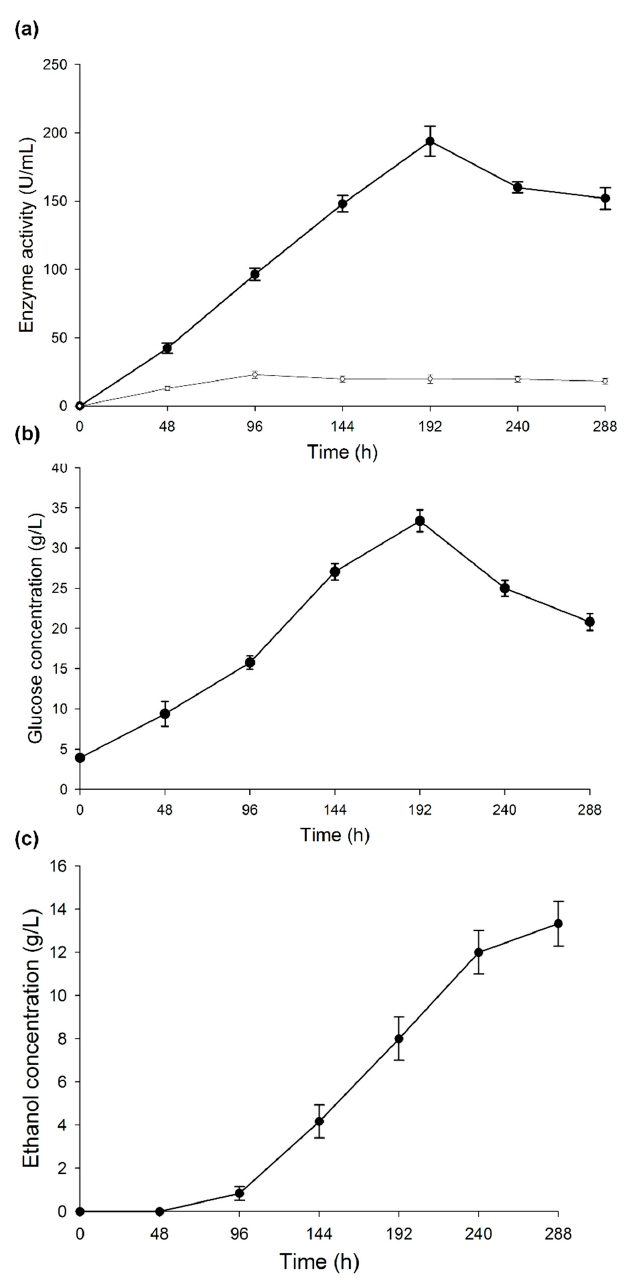
Figure 3. Changes during consolidated bioprocess. ( a ) α -amylase and laccase activities, ( b ) glucose concentration, and ( c ) ethanol concentration. Results are represented as the mean ± standard deviation of three parallel measurements ( n = 3).